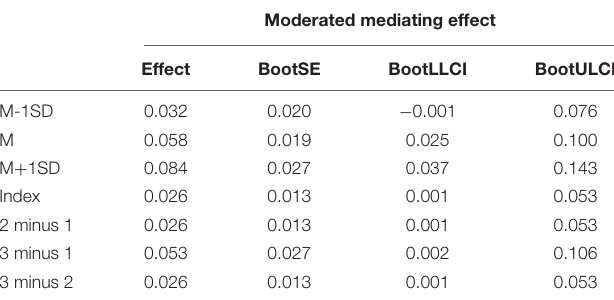
TABLE 8 | Moderated mediating effect of victim sensitivity.